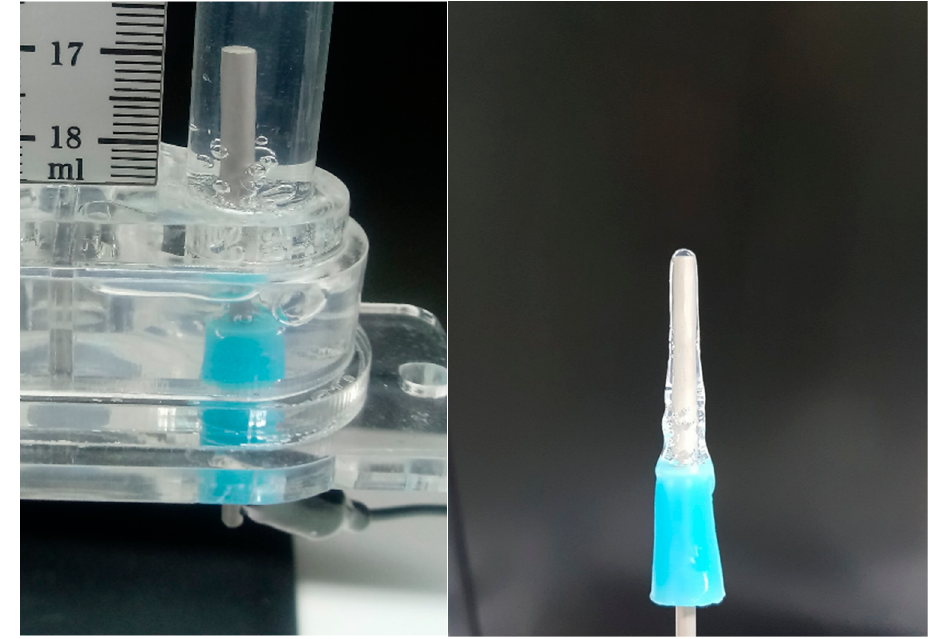
Figure 3. Coated CNF at the anode.